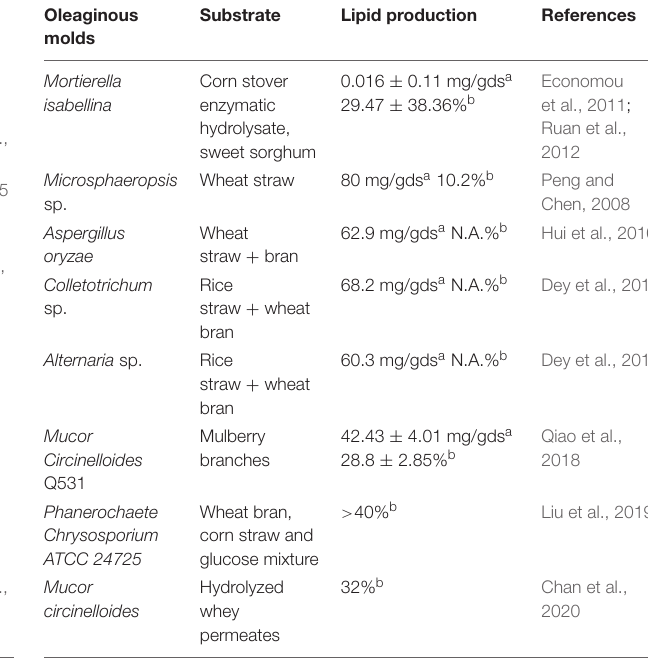
TABLE 2 | Lipid production by oleaginous molds using lignocellulosic